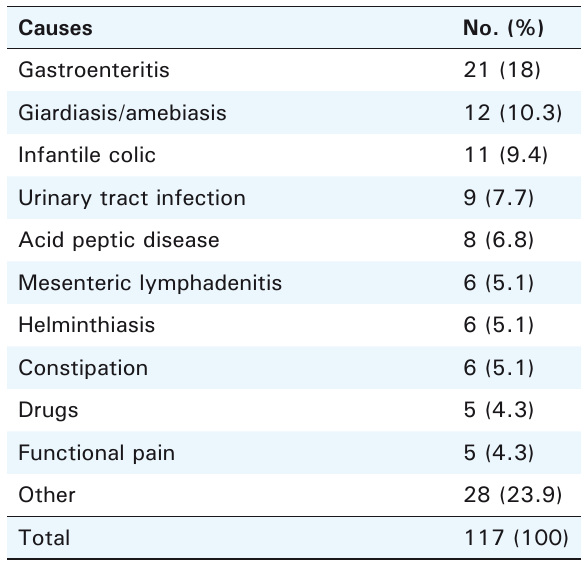
table 4. Common causes of pain abdomen according to frequency